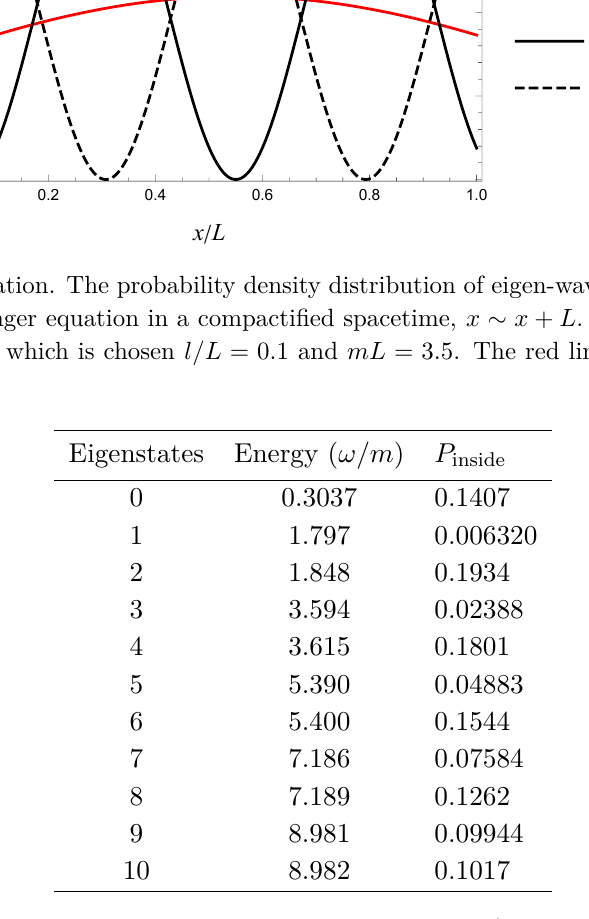
which is exponentially suppressed for e − A ( r b ) ∼ 10 − 14 and typical values for mZ ' r